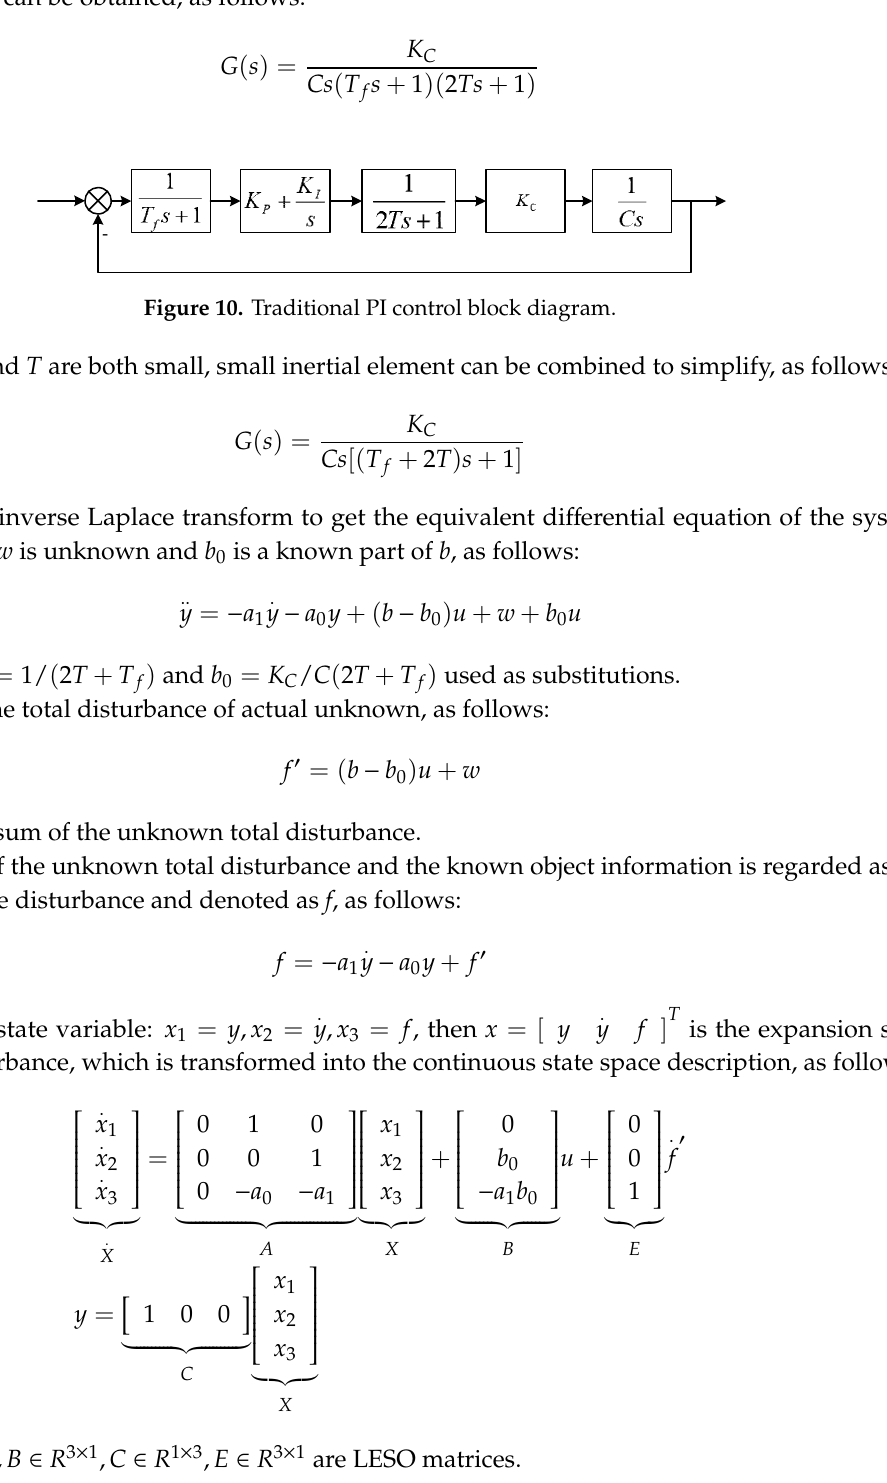
10 of 20 Figure 8. Control system structure. Under the traditional single closed-loop control strategy, feed-forward decoupling is often used to deal with the coupling term. Because this decoupling method increases the difficulty of controller design and the uncertainty of parameters, it is hindered in practical application. When inputs and outputs are in one-to-one correspondence, cross-effects (coupling) between channels are estimated by the LESO and eliminated as disturbances in each single input single output loop. In other words, the cross coupling is naturally decoupled, so the FLS-LESO has naturally decoupling characteristic. Due to the complexity and uncertainty of transient process dynamics, it is impossible for the process model to be completely accurate and reliable. Due to its natural decoupling capability, the FLS-LESO far outperforms PID and other model-based methods in controlling coupled systems, and its controller structure is shown in Figure 9. K P Fuzzy inference